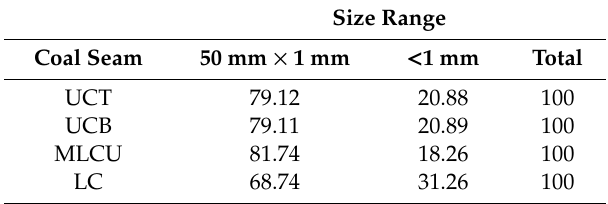
Table 1. Size distribution in mass (wt%) of the coal layers (UCT, UCB, MLCU, and LC).